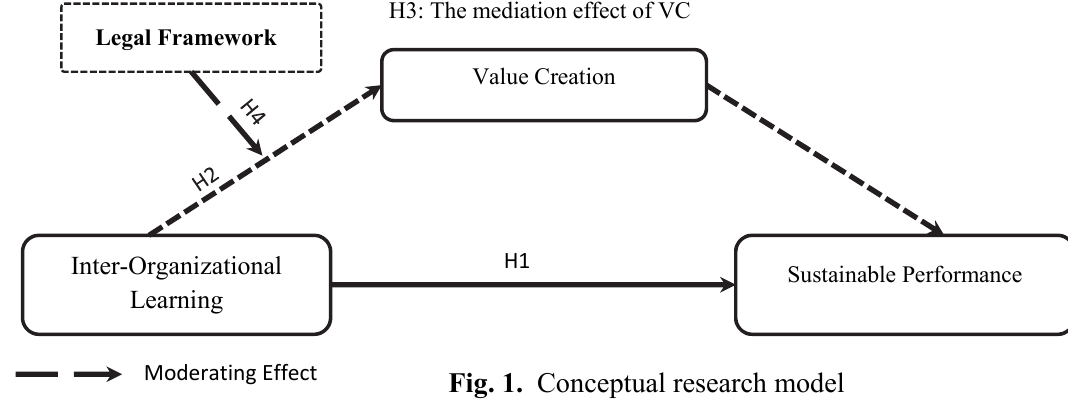
Fig. 1. Conceptual research